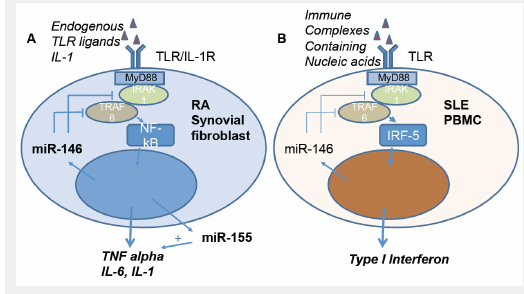
Regulatory role of miR-146 and miR-155 on inflammation in activated synovial fibroblasts of patients with rheumatoid arthritis (A) and on type I interferon production in PBMC of patients with SLE (B). (A) Activation of synovial fibroblasts by endogenous Toll- like receptor (TLR) ligands or interleukin 1 (IL-1) initiates a signalling cascade via nuclear factor kappa B (NF-κB) resulting in expression of proinflammatory cytokines, such as tumour necrosis factor alpha (TNF-α). Overexpression of TNF-α is a hallmark of rheumatoid arthritis. In activated synovial fibroblasts miR-155 expression is induced, further enhancing TNF-α production. In contrast, miR-146 has a modulatory role by inhibiting the signalling molecules interleukin 1 associated receptor kinase 1 (IRAK1) and TNF-receptor accessory factor 6 (TRAF 6). (B) Regulatory role of miR-146 in SLE PBMC. In contrast to the overexpression of miR-146 in RA, in SLE miR-146 levels are decreased, resulting in an increased activation of IRF-5 and expression of type 1 interferon. IRF-5 = interferon regulatory factor 5; PBMC = peripheral blood mononuclear cells; RA = rheumatoid arthritis; SLE = systemic lupus